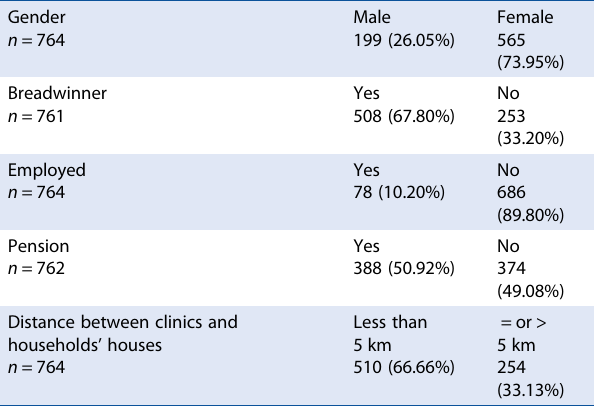
Table 1: Baseline characteristics (gender, breadwinner, employed, pension and distance between house and